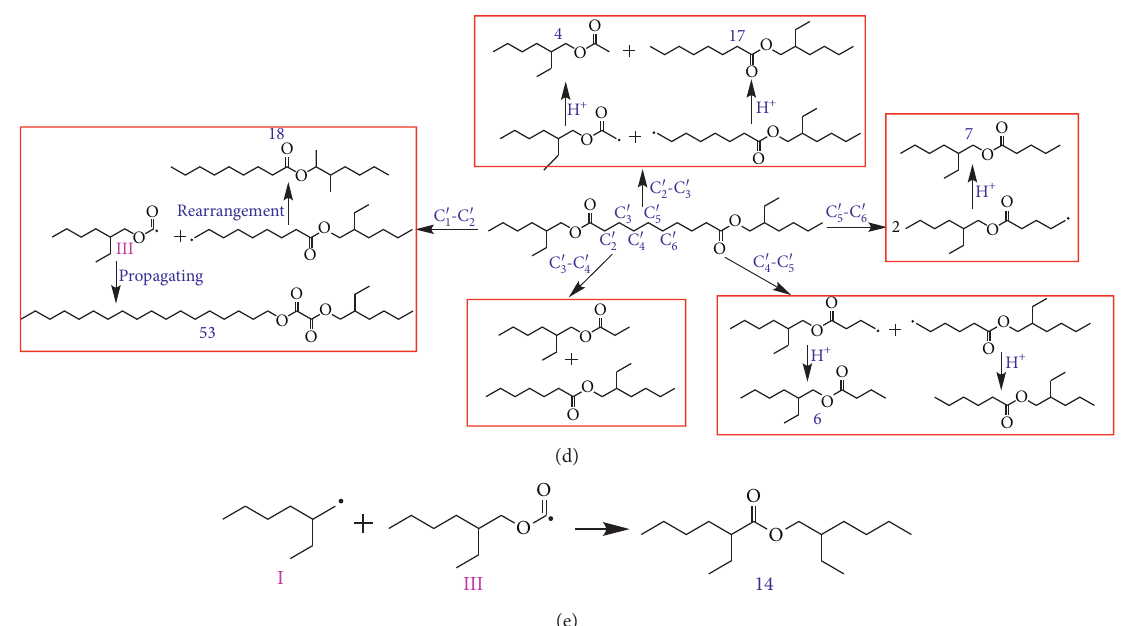
Figure 10: Possible mechanism for thermal oxidation of BEHDD. (a) Cleavage of the C–O ester bond, (b) cleavage of the C alcohol chain, (c) cleavage of the β -H bond in alcohol chain, (d) cleavage of the C–C bond in ester chain, and (e) formation of compound 14